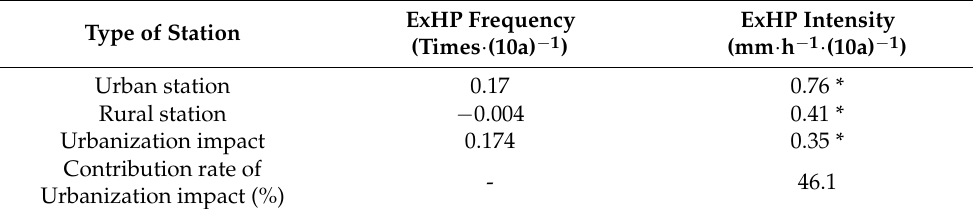
Table 3. Urbanization impact and its contribution rate (%) on annual extreme hourly precipitation frequency and intensity at urban and rural stations in Liaoning Province from 1974 to